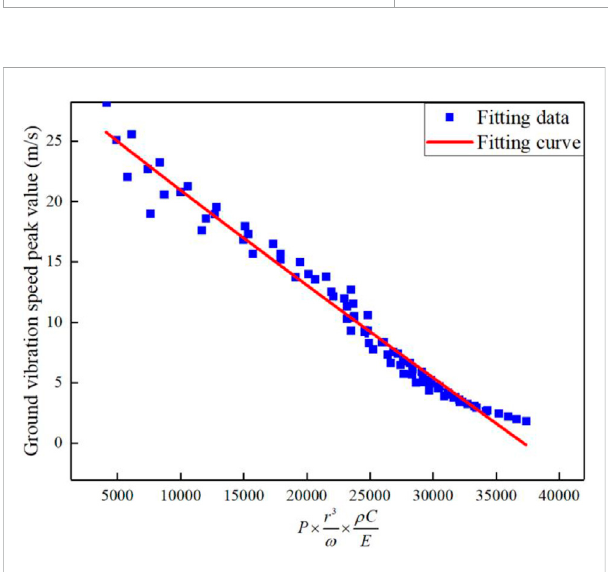
FIGURE 7 Functional relationship fi tting effect.